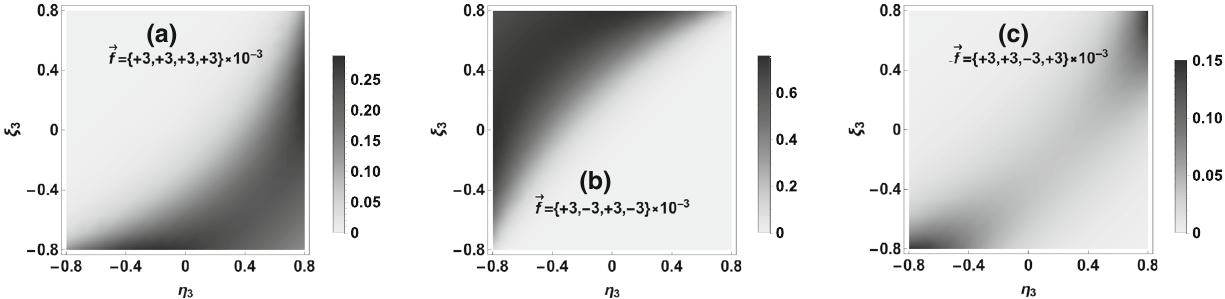
√ s = 500 GeV and L = 100 fb − 1 in Z Z